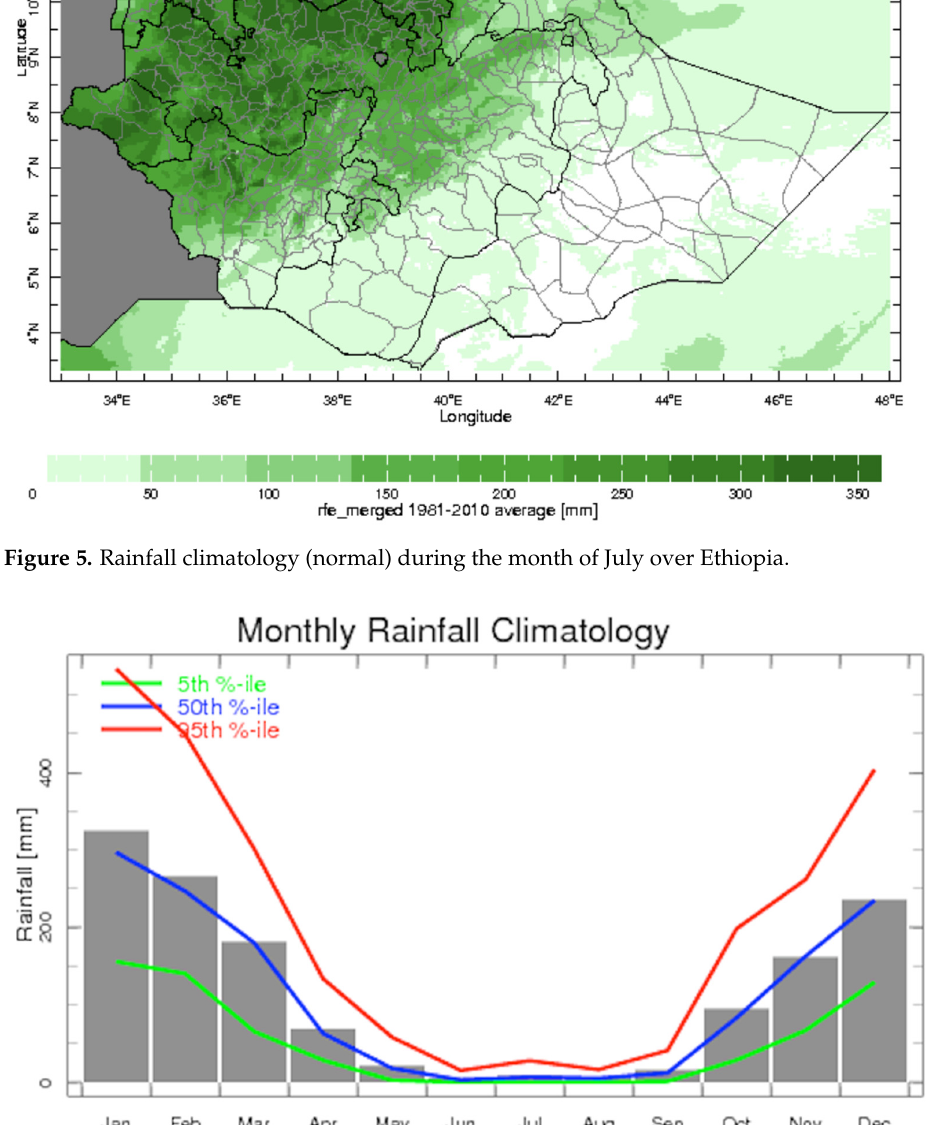
Figure 6. Seasonality of rainfall for a specific location over Madagascar. The bars show the mean rainfall (climatology) for each month, while green, blue, and red lines show the 5th, 50th, and 95th percentiles, respectively. The 5th and 95th percentiles are included here to show the minimum and maximum ranges (variance) of the